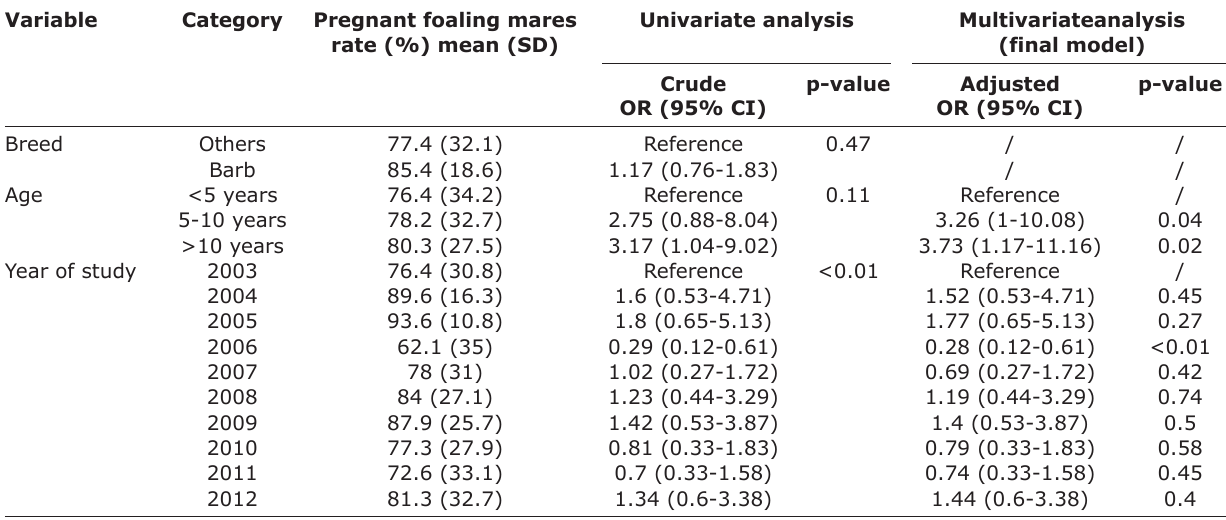
SD=Standard deviation, OR=Odds ratio, CI=Confidence Table-3: Influence of the age of the stallion and the year of the study on the number of foaling pregnant mares. Variable